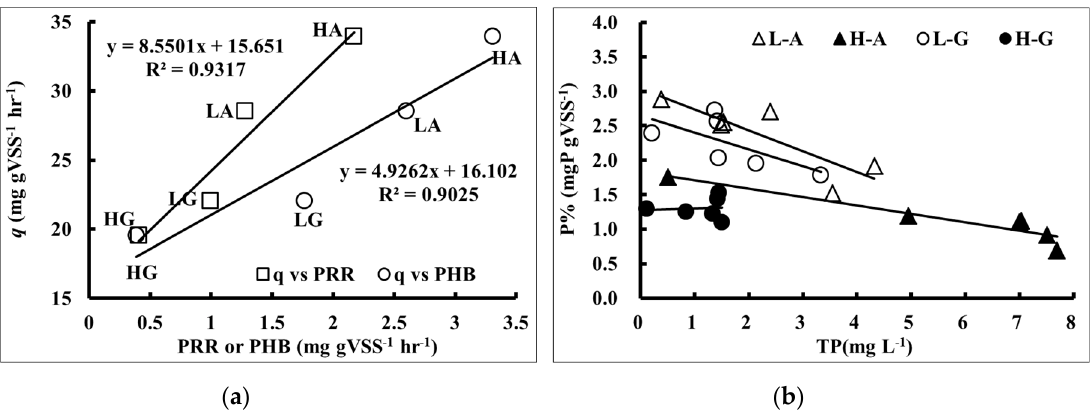
Figure 3. ( a ) TP and P% correlation; ( b ) TP and poly-b-hydroxyalkanoate (PHA) correlation diagrams. (L-A: low concentration acetic acid, H-A: high concentration acetic acid, L-G: low concentration glucose, H-G: high concentration glucose ).